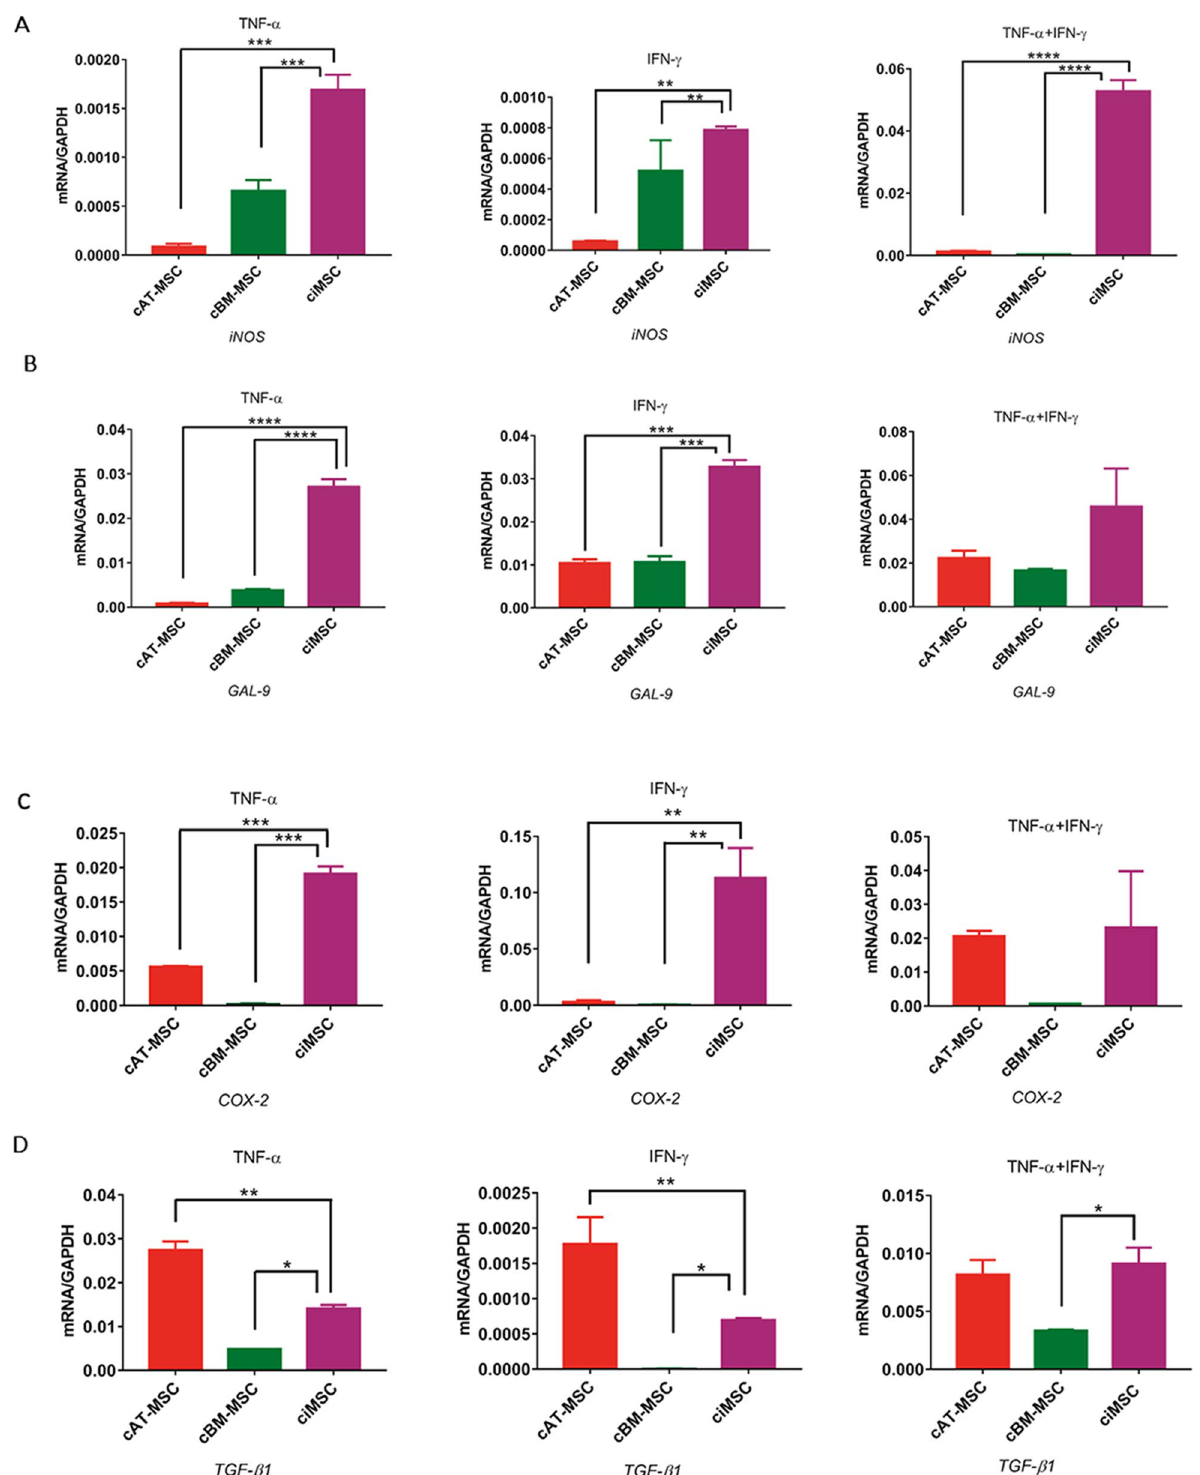
Figure 3. Response of ciMSCs, cAT-MSCs and cBM-MSCs to priming with pro-inflammatory cytokines canine tumor necrosis factor-α (cTNF-α), canine interferon-γ (cIFN-γ) and a combination of both (cTNF-α + cIFN-γ). When stimulated with cTNF-α, cIFN-γ, or a combination of both, ciMSCs upregulated their expression of : ( A ) iNOS ; ( B ) GAL-9; ( C ) COX-2; ( D ) TGF-β; ( E ) PTGER-2α; ( F ) IDO; ( G ) HGF; ( H ) VEGF; ( I ) IL-8 and ( J ) IL-1β. Significance is defined as: ns = not significant p > 0.05; * p ≤ 0.05; ** p ≤ 0.005; *** p ≤ 0.0002; **** p ≤